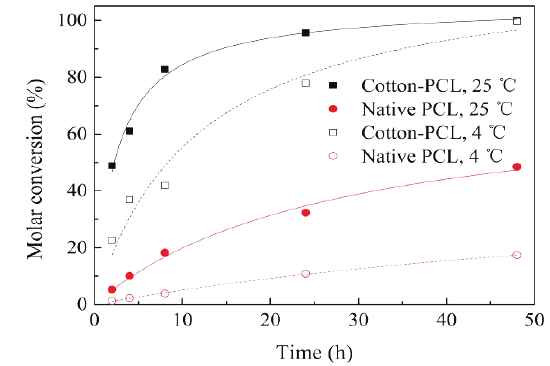
Figure 7: Linear fitting of coordinate points by taking conversion as A value and time as t value, based on the Figure 6.